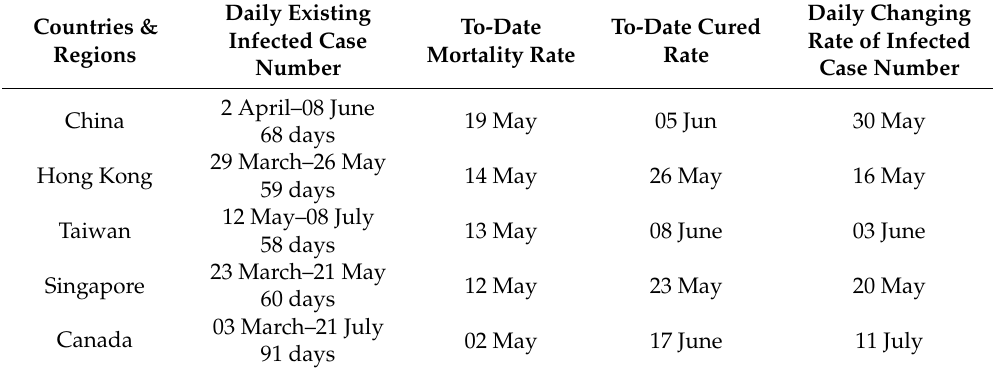
Table 6. Peak periods and rate stabilising dates in the SARS